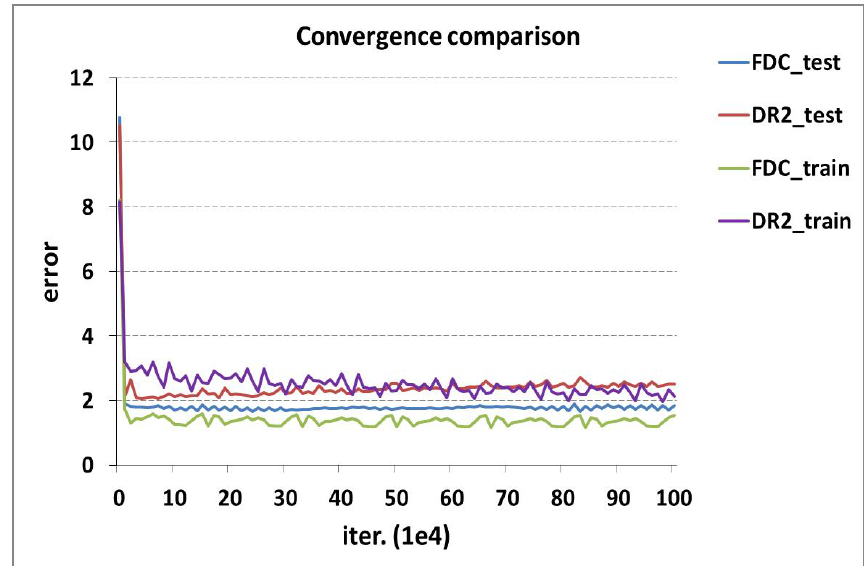
Figure 7. Convergence comparison between FDC-Net and DR 2 -Net. It is obvious that our FDC-Net has smaller training error and test error than DR 2